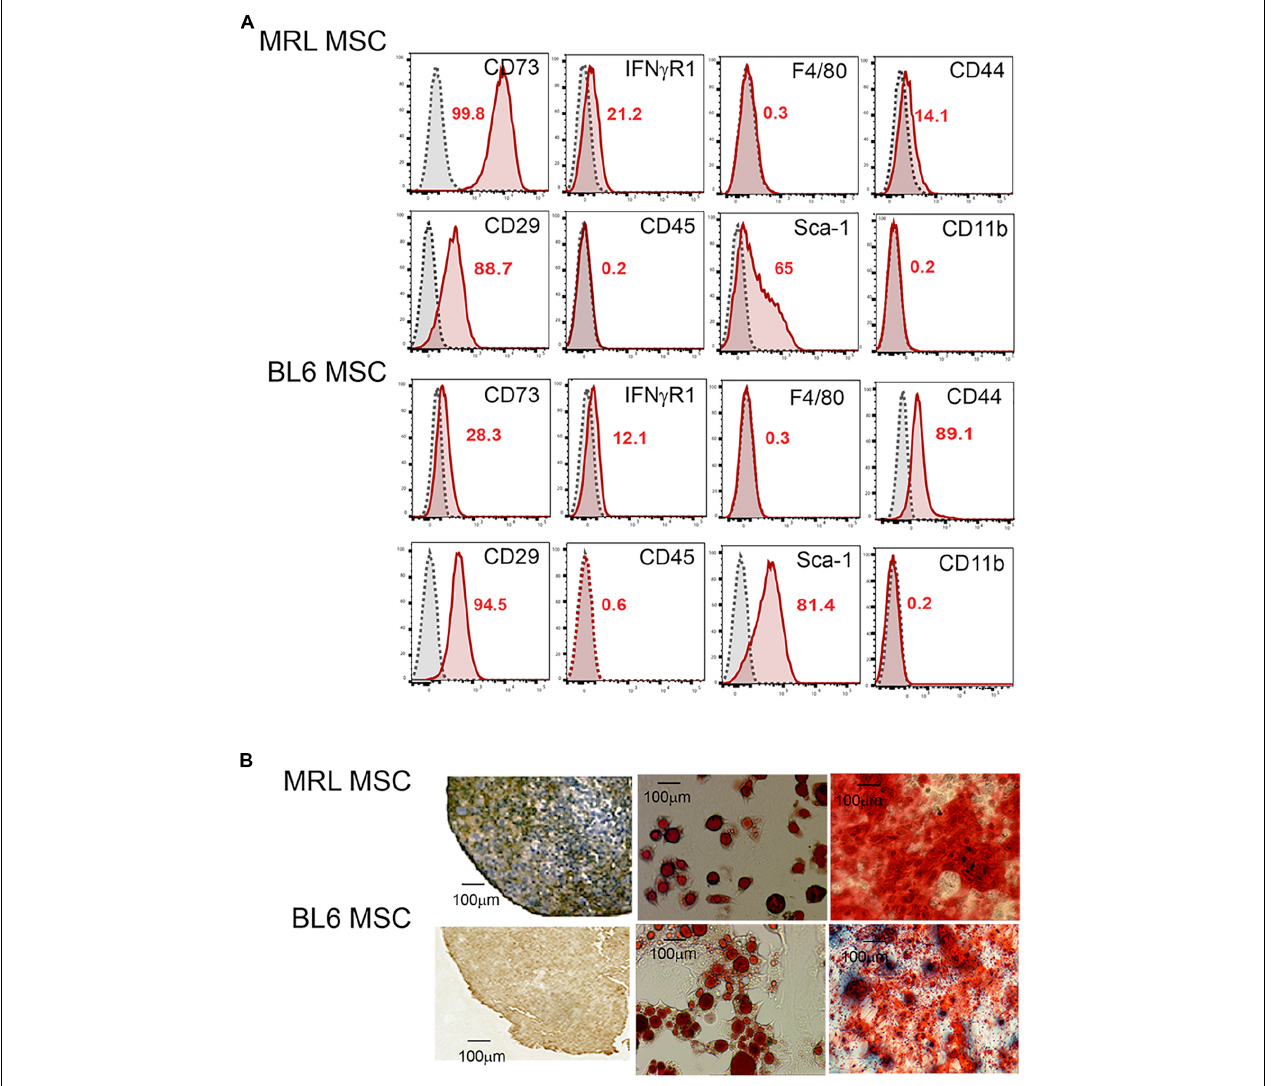
FIGURE 1 | MRL MSC and BL6 MSC have the same phenotype and differentiation potential. (A) Phenotype of MRL and BL6 MSC was assessed by flow cytometry using different antibodies that include CD73, IFN γ R1, F4/80, CD44, CD29, CD45, SCA-1, and CD11b. The percentages of positive cells are indicated in red in the flow cytometry data. (B) Differentiation potential of MSC. The chondrogenic differentiation of MRL and BL6 MSC was assessed using an anti-aggrecan positive staining on pellet sections. The adipogenic potential of MSC was by the visualization of lipid droplets by phase contrast microscopy at day 21 of the differentiation process. Finally, the osteogenic differentiation potential of MSC was defined by Alizarin Red S positive